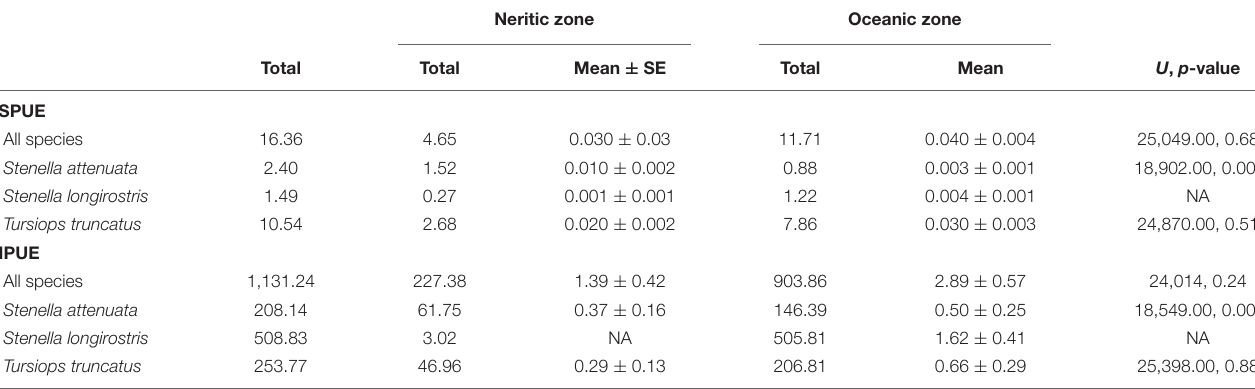
TABLE 3 | Sightings per unit effort (SPUE) and dolphins per unit effort (IPUE) for all small cetacean species and the most common species sighted of the Pacific waters of Guatemala. Neritic zone Oceanic